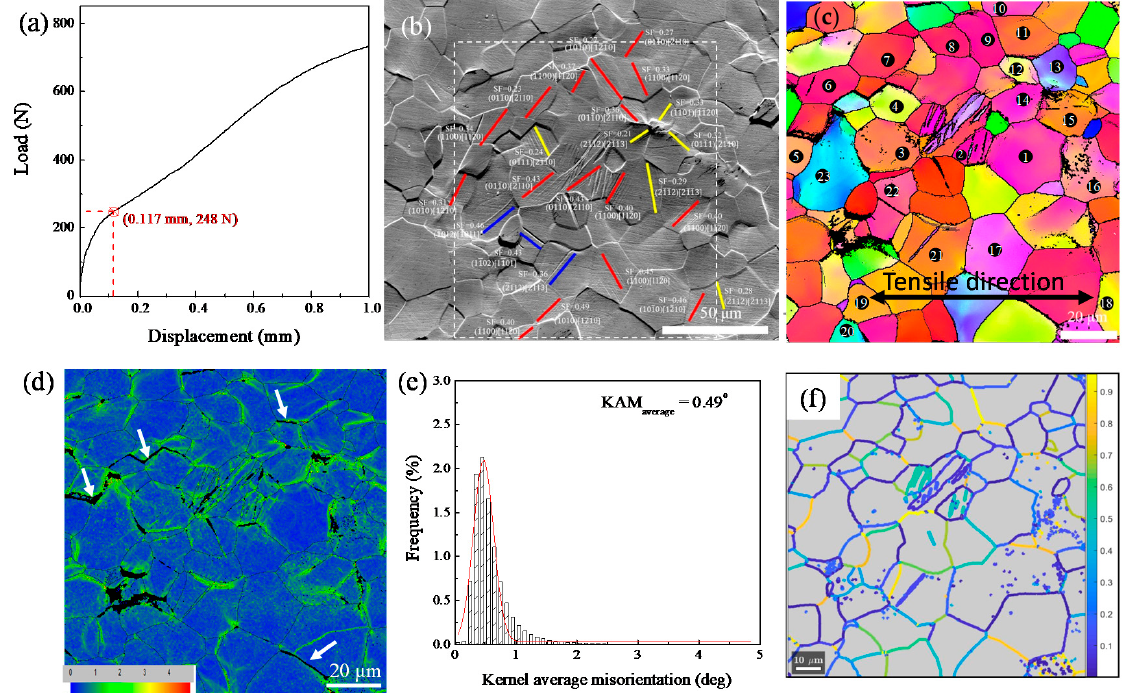
Figure 2. The displacement-load curve and the deformed microstructures of TA2 during in situ tensile test: ( a ) displacement-load curve, ( b ) SEM image, ( c ) IPF, ( d ) KAM map, ( e ) frequency distribution of KAM, and ( f ) the geometric compatibility factor ( (cid:1865) (cid:4593) ) distribution map of the prismatic slip.